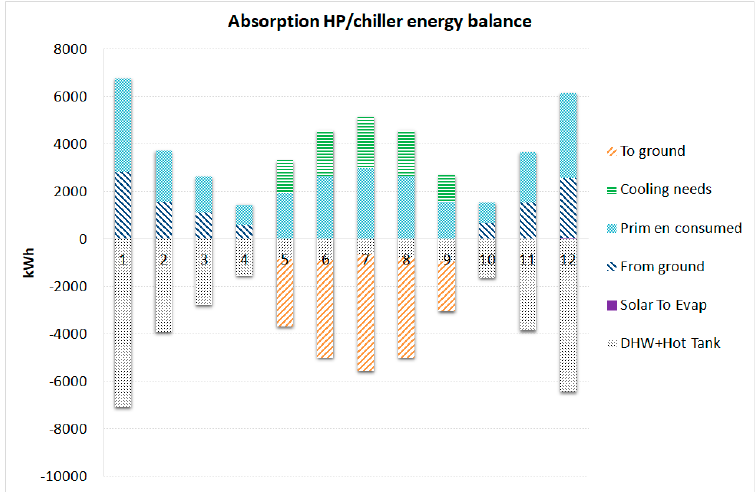
Figure 12. Absorption HP/chiller energy balance for the A3 alternative.